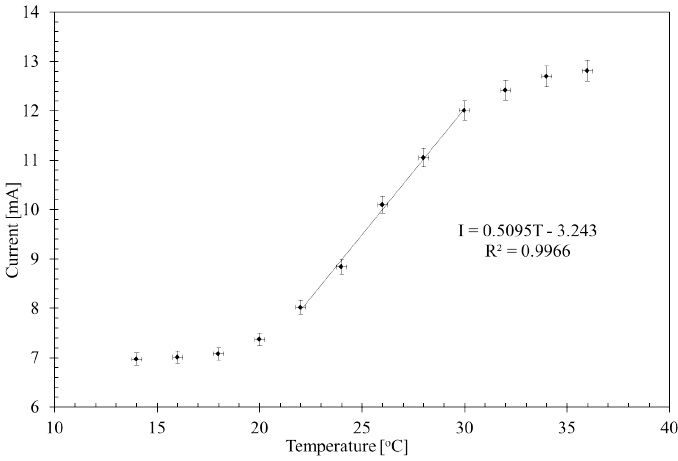
Figure 10. Output current as a function of